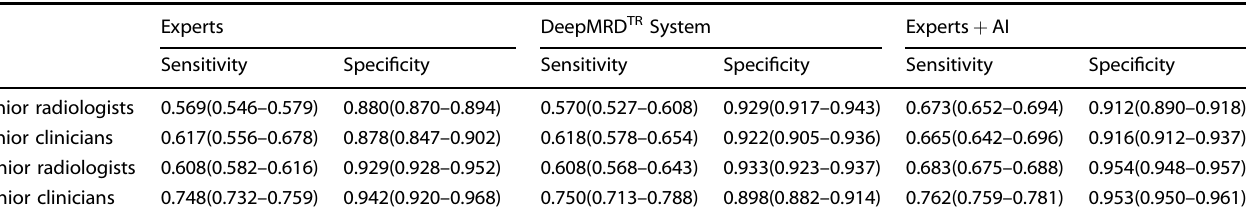
Table 2. Comparison and combination of sensitivity and speci fi city between experts ’ reading results and the proposed DeepMRD TR